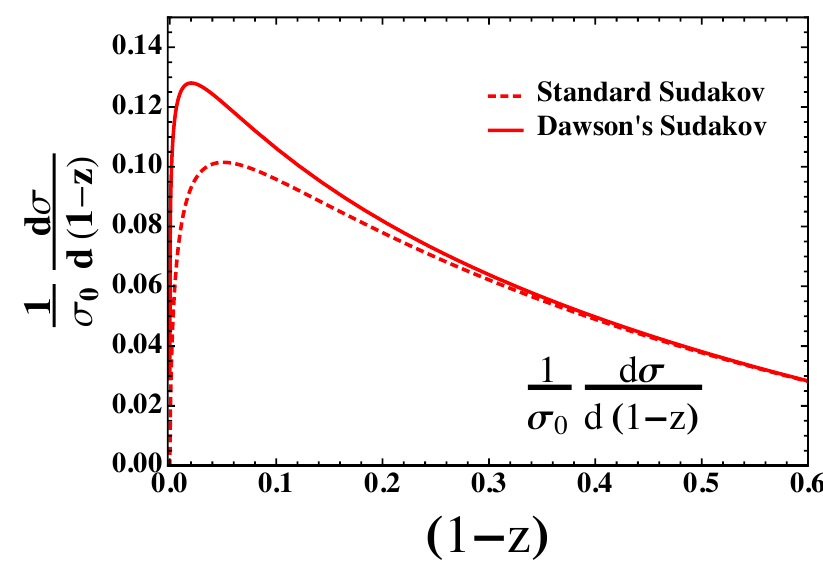
Figure 2 . A comparison of the standard Sudakov exponential which describes the all orders exponentiation of the leading power logarithms for the EEC with the subleading power Sudakov involving the imaginary error function (er(cid:12)) derived in this section, which we refer to as Dawson’s Sudakov. Dawson’s Sudakov exhibits a more peaked structure as z chosen to plot the numerical